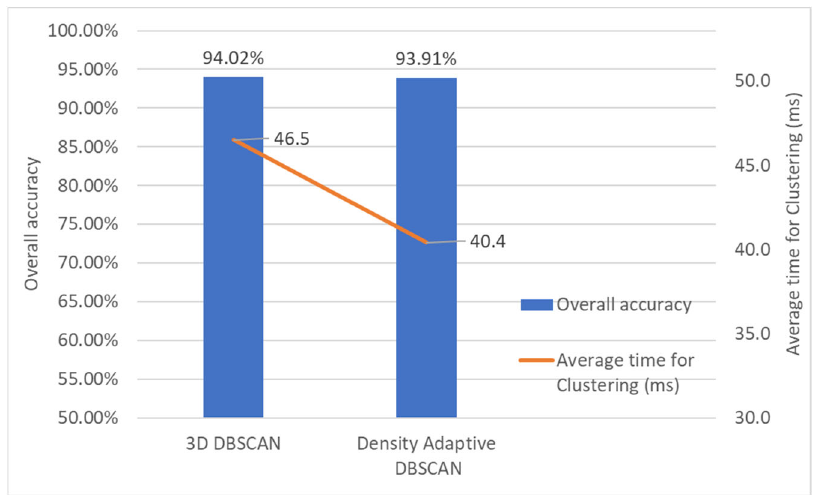
Figure 20. The performance of 3D ‐ clustering and post ‐ projection ‐ clustering methods.